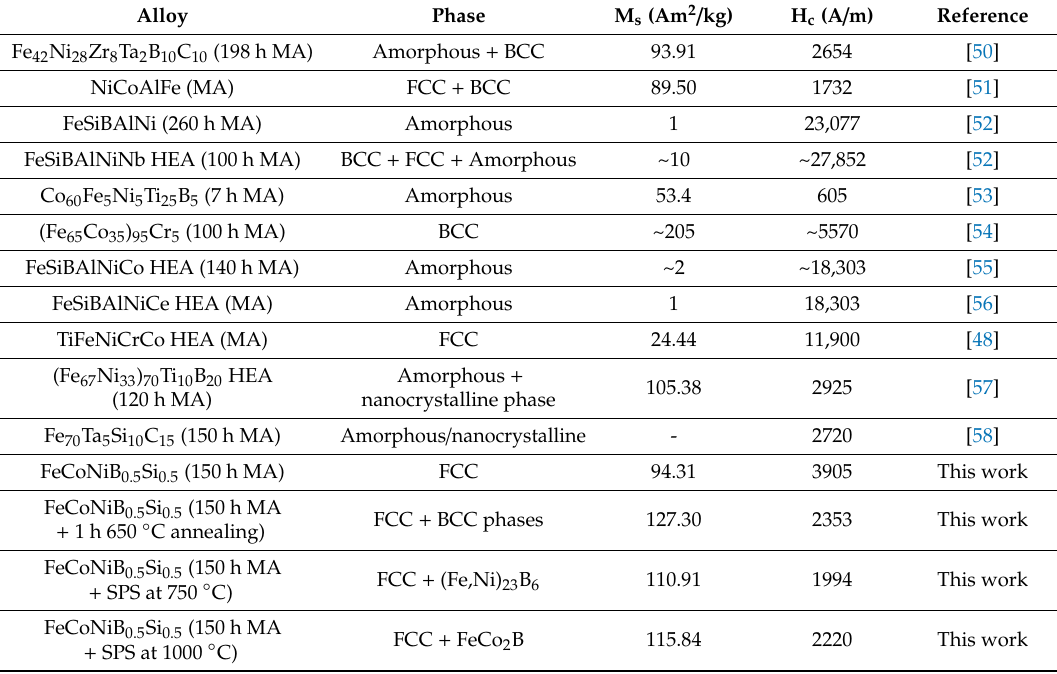
Table 6. Comparison of magnetic characteristics of some reported HEAs with the present